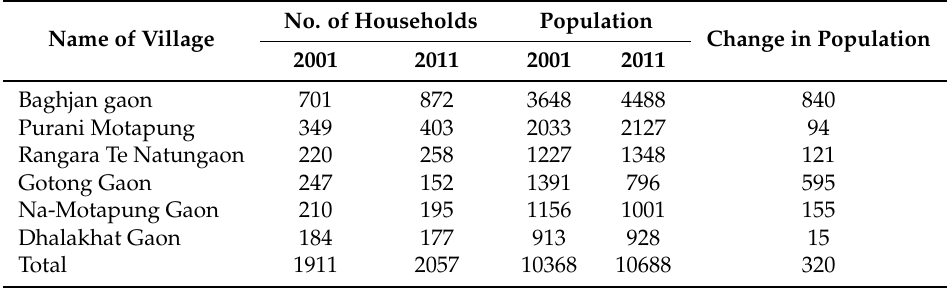
Table 1. Total number of households and population in 2001 and 2011 in surrounding villages of the study wetland. This shows that there has been little overall change in the population during this period. Source: National Census Report 2001 and 2011, available at http://www.censusindia.gov.in (cited on 24 August